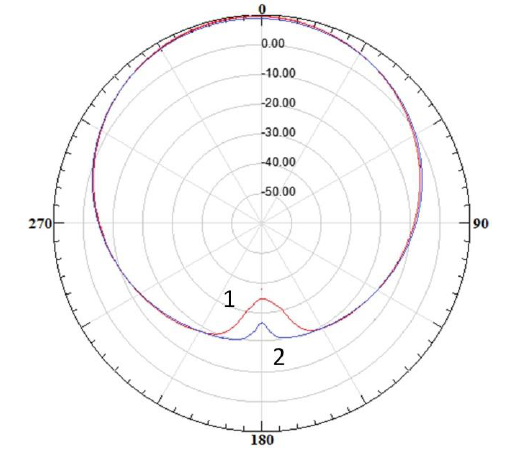
Fig. 5. Radiation patterns in H-plane (1 - mesh patch, 2 - solid